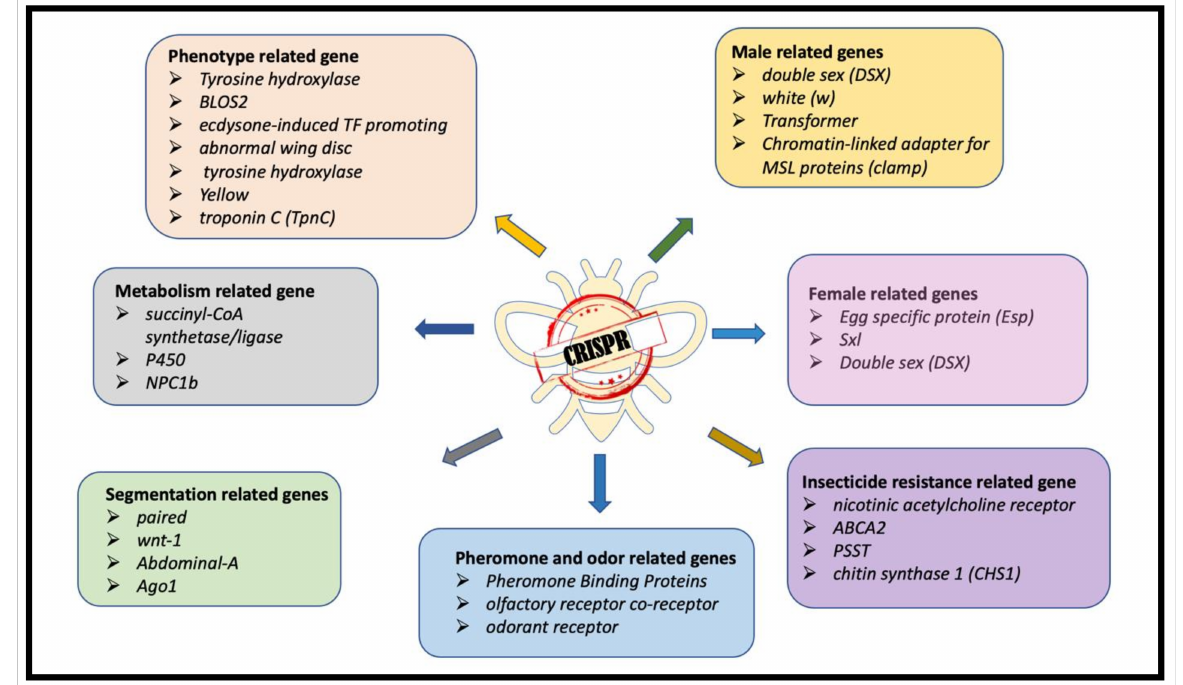
Figure 1. The figure shows various genes targeted by CRISPR/Cas9 for insect pests